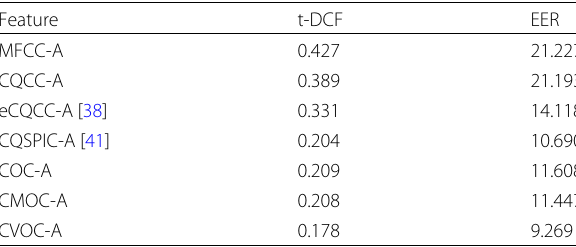
ASVspoof 2019 physical access evaluation set in terms of